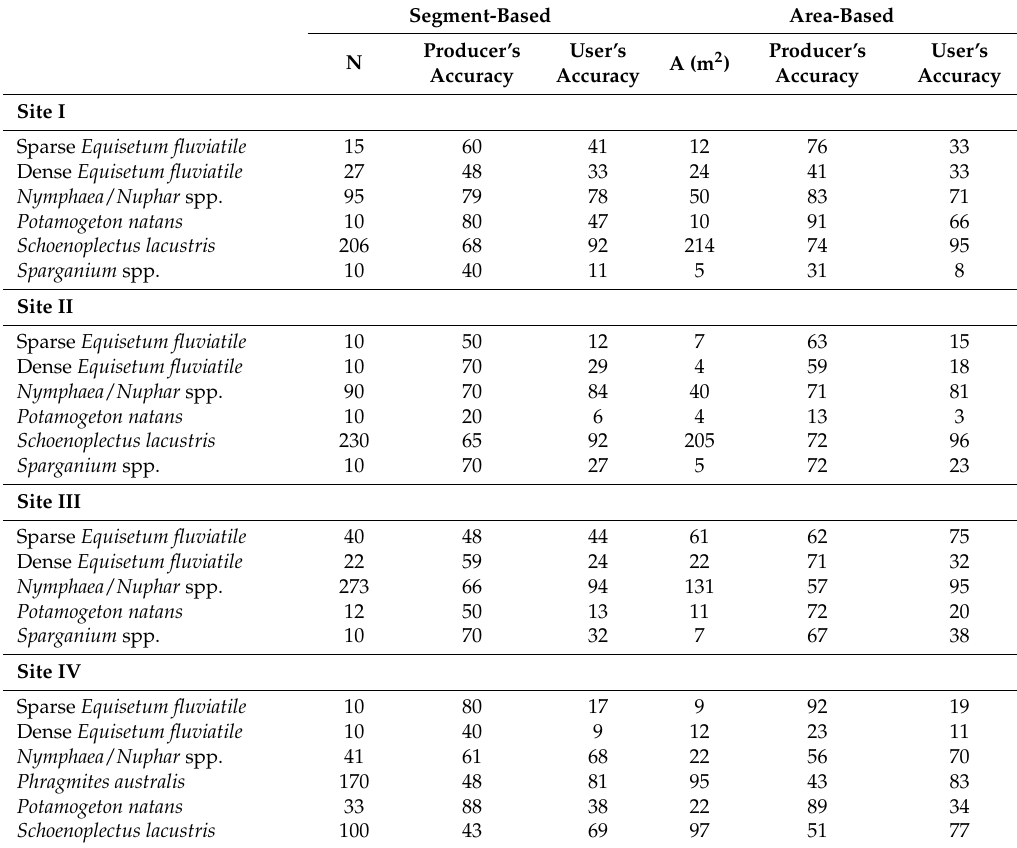
Table 7. Producer’s and User’s accuracy (%) of dominant taxa using Random Forest classification, number of validation segments (N) and total area of validation segments